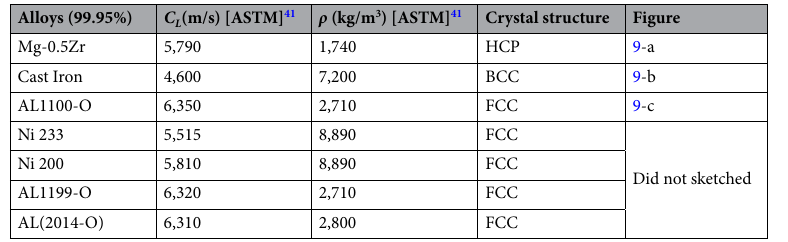
Table 3. Properties of alloys unlisted in Table